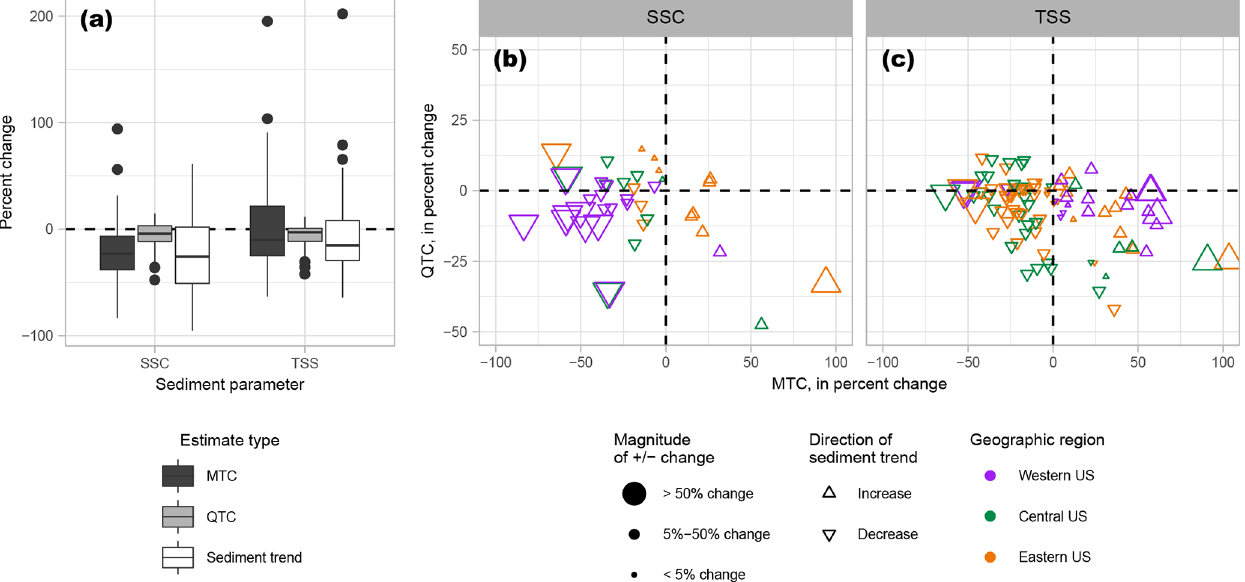
Figure 3. (a) Boxplots of sediment trend, management trend component (MTC) and streamflow trend component (QTC) estimates by sediment parameter. See description of boxplots in the caption of Fig. 2. (b, c) Bivariate plots of QTC versus MTC for each site by sediment parameter, color coded by geographic region and sized by the magnitude of sediment trend. Note that panels (b) and (c) exclude one undeveloped western US site (BRSS0035) with 195% MTC, 7% QTC and 202% sediment trend. Recall, at a given site, the sediment trend is equal to MTC + QTC.